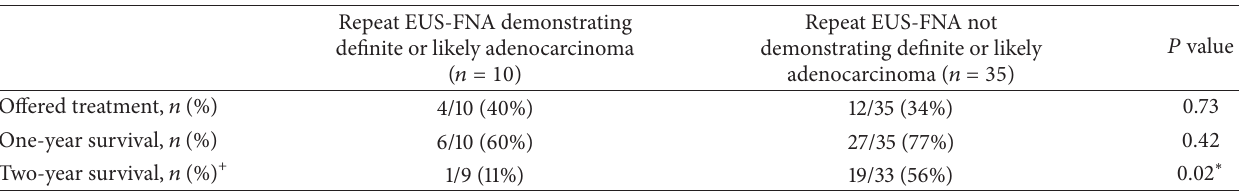
Table 5: Comparison of treatment and survival between patients by cytopathologic classes of repeat EUS-FNA for suspected pancreatic malignancy at St. Paul’s Hospital, Vancouver, British Columbia, between 2007 and 2014. Repeat EUS-FNA demonstrating Repeat EUS-FNA not 𝑃 value definite or likely adenocarcinoma demonstrating definite or likely ( 𝑛 = 10 ) adenocarcinoma ( 𝑛 = 35 ) Offered treatment, 𝑛 (%) 4/10 (40%) 12/35 (34%) 0.73 One-year survival, 𝑛 (%) 6/10 (60%) 27/35 (77%) 0.42 Two-year survival, 𝑛 (%) + 1/9 (11%) 19/33 (56%) 0.02 ∗ Treatment and survival and one and two years among 45 patients with suspected pancreatic cancer who underwent repeat EUS-FNA (EUS-FNA: endoscopic ultrasound fine-needle aspiration; SD: standard deviation; ∗ indicates statistical significance, 𝑃 < 0.05 ; + calculated only for 42/45 patients recruited into the study prior to May